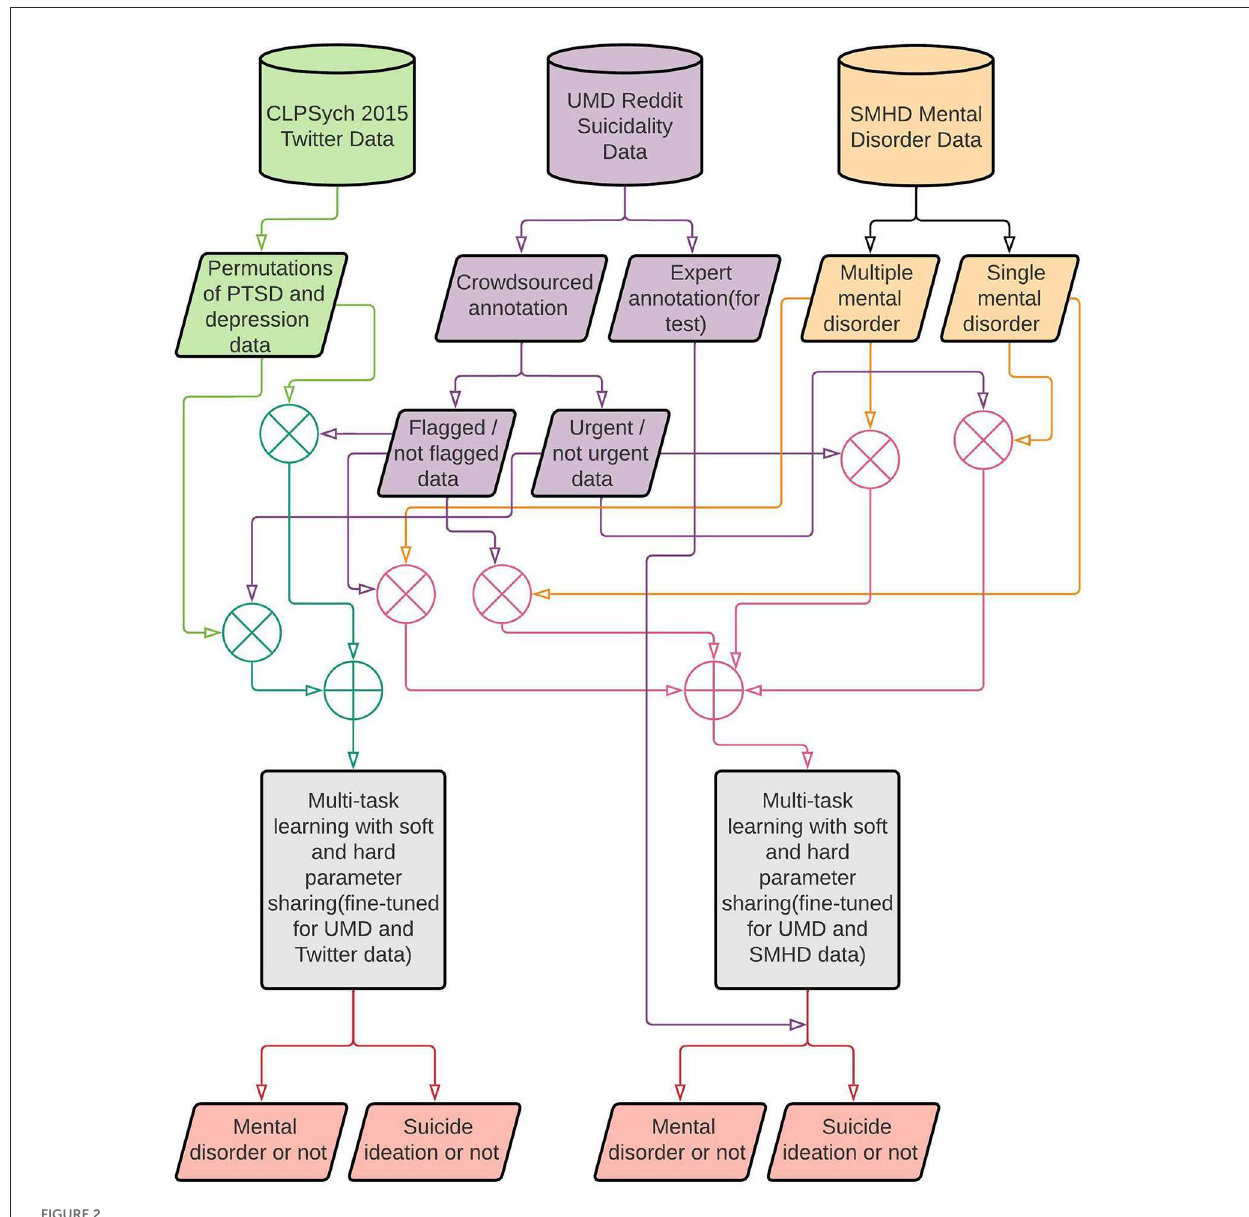
FIGURE2 Research